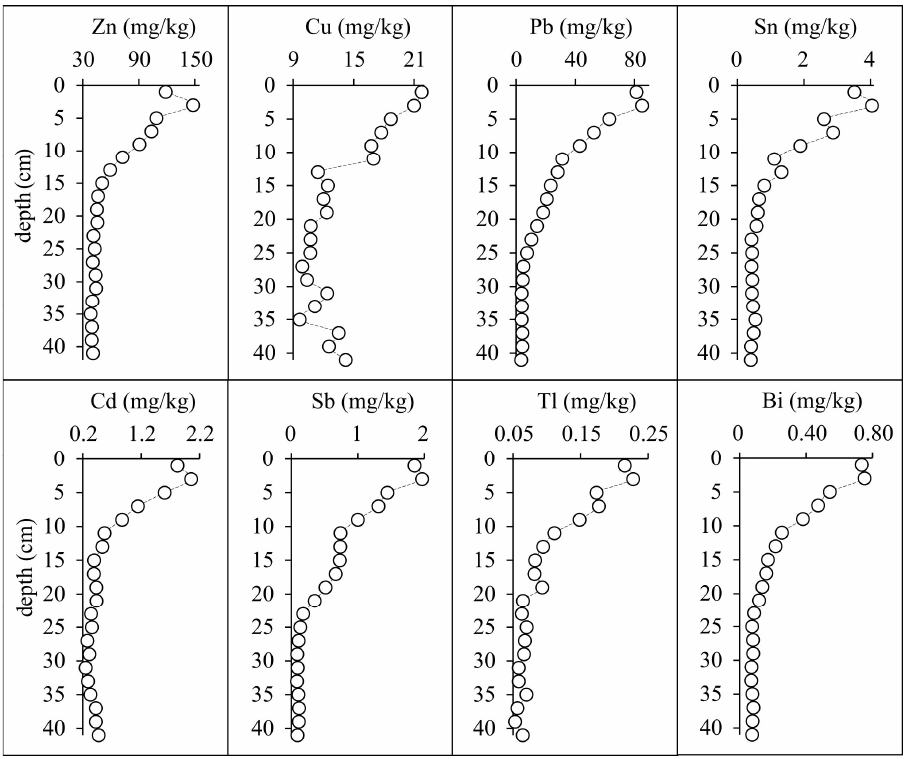
Figure 16. The vertical distribution of Pb in sediments of Lake Liunkunlampi (the Republic of Karelia) [98].